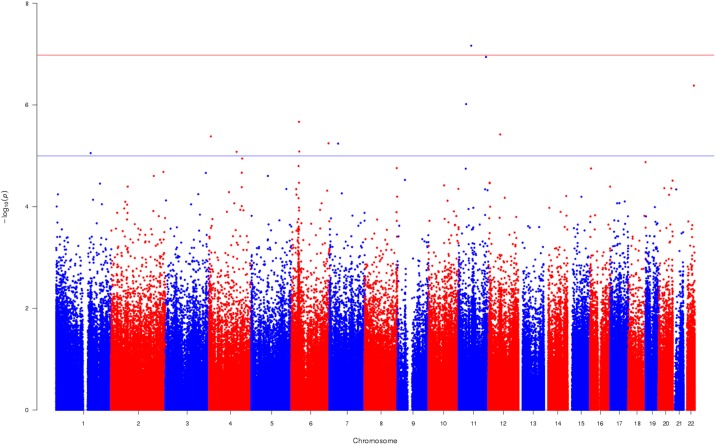
Manhattan plot indicating the associations between DBP and DNA methylation of men of European and South Asian ancestry.The plot demonstrates the associations between DBP and DNA methylation of European and South Asian men collectively. The model was adjusted for confounders, estimated cell counts and principal components. The uncorrected log10(p-values) are plotted on the y-axis. The blue line is drawn to separate the CpG sites that surpassed p-value<1×10−05, a threshold for a suggestive association and the red line to separate the CpG sites that surpassed the Bonferroni-corrected threshold (p-value<1.24×10−07). The CpG sites that surpassed the Bonferroni-corrected threshold were considered to be associated with the trait.